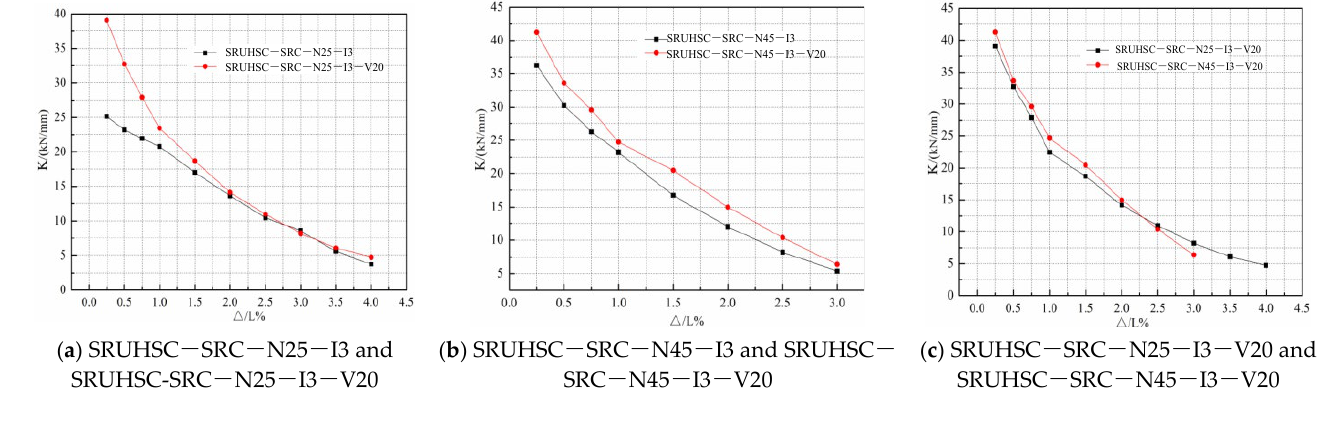
Figure 8. Comparison of stiffness degradations.